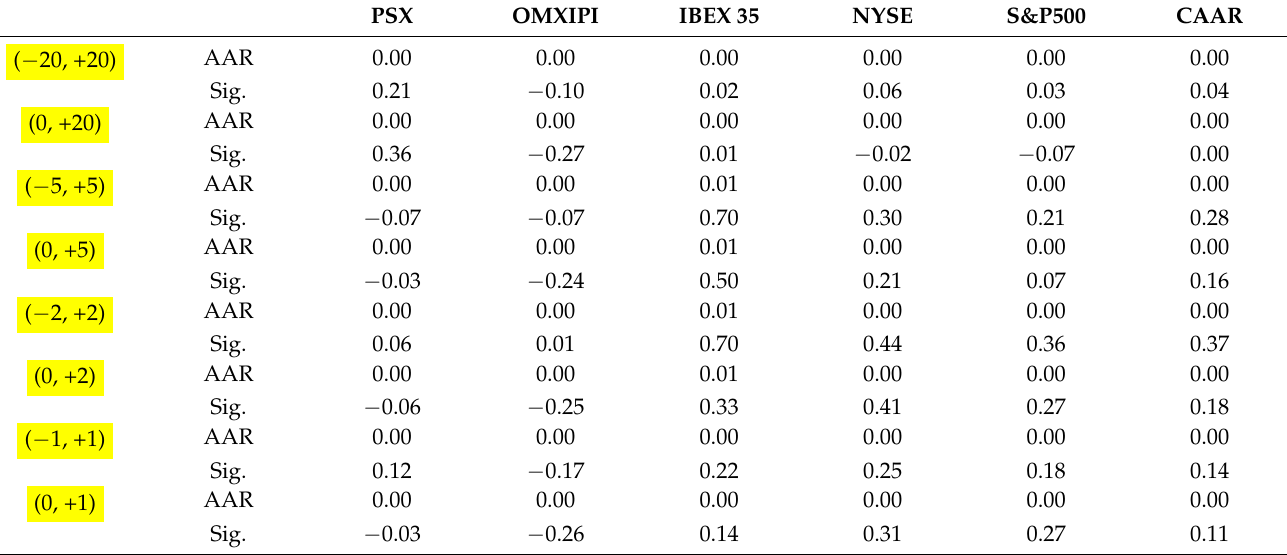
Table A40. Average abnormal returns and cumulative average abnormal returns (Resignation of D. Jos é Manuel Soria, Spain’s Minister of